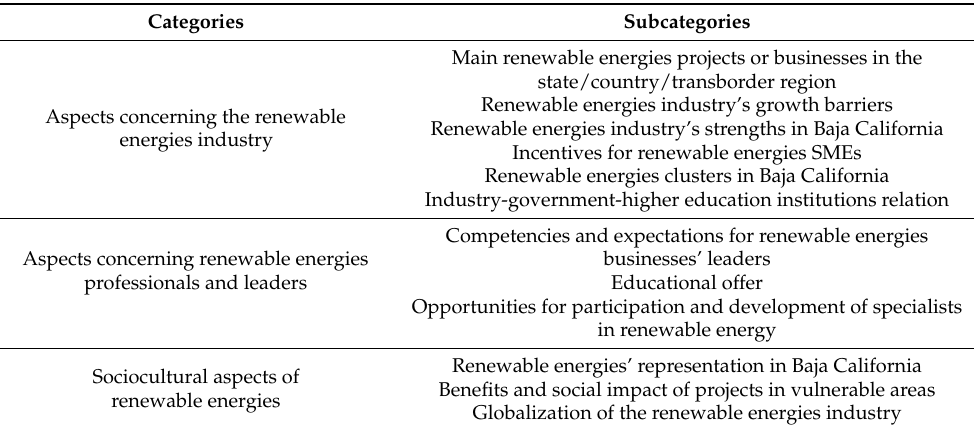
Table 2. Categories and subcategories for content analysis of interviews to